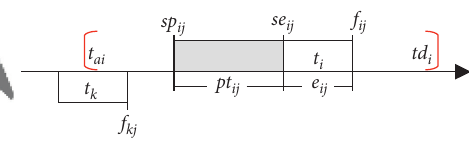
Figure 1: The task assigning